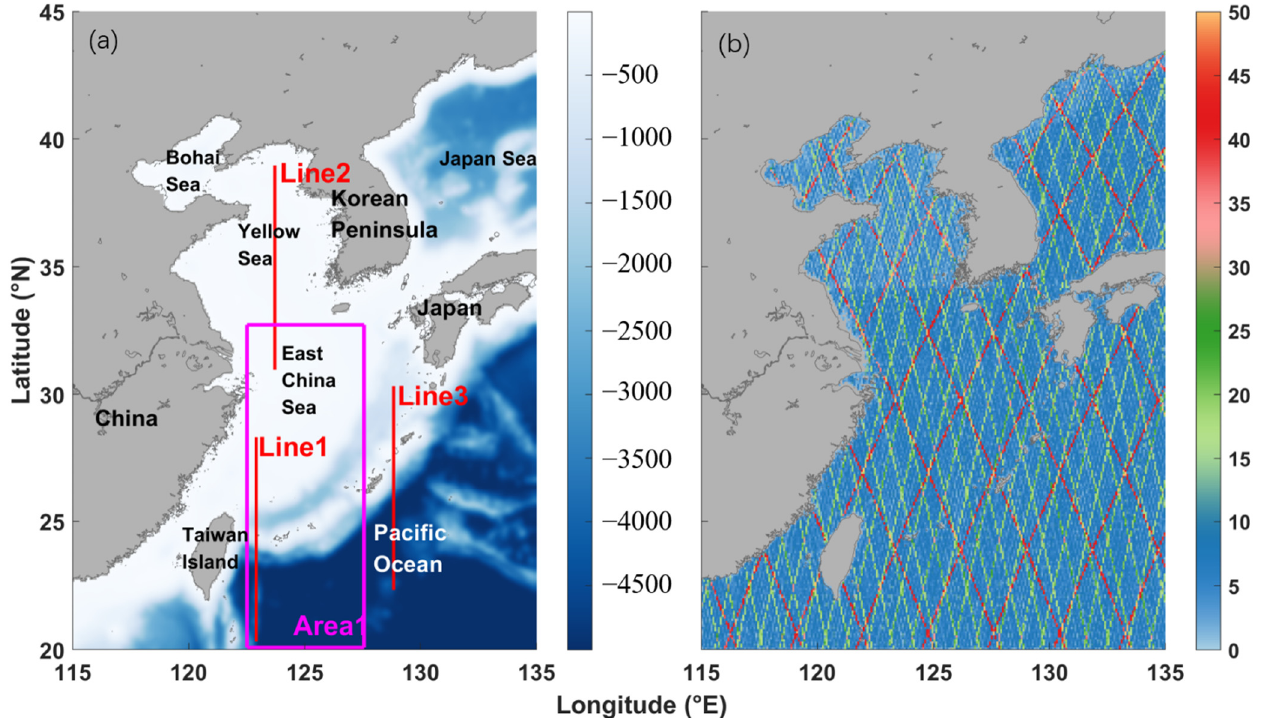
Figure 1. ( a ) Study area (115–135 ◦ E, 20–45 ◦ N) showing the East China Sea and its adjacent areas. The background color is water depth (m), the purple box delineates the sampling area for the wavenumber frequency analysis and the solid red lines are the sampling locations for the time evolution analysis of normalized geostrophic vorticity. ( b ) Number of times satellite altimeters passed over the region in